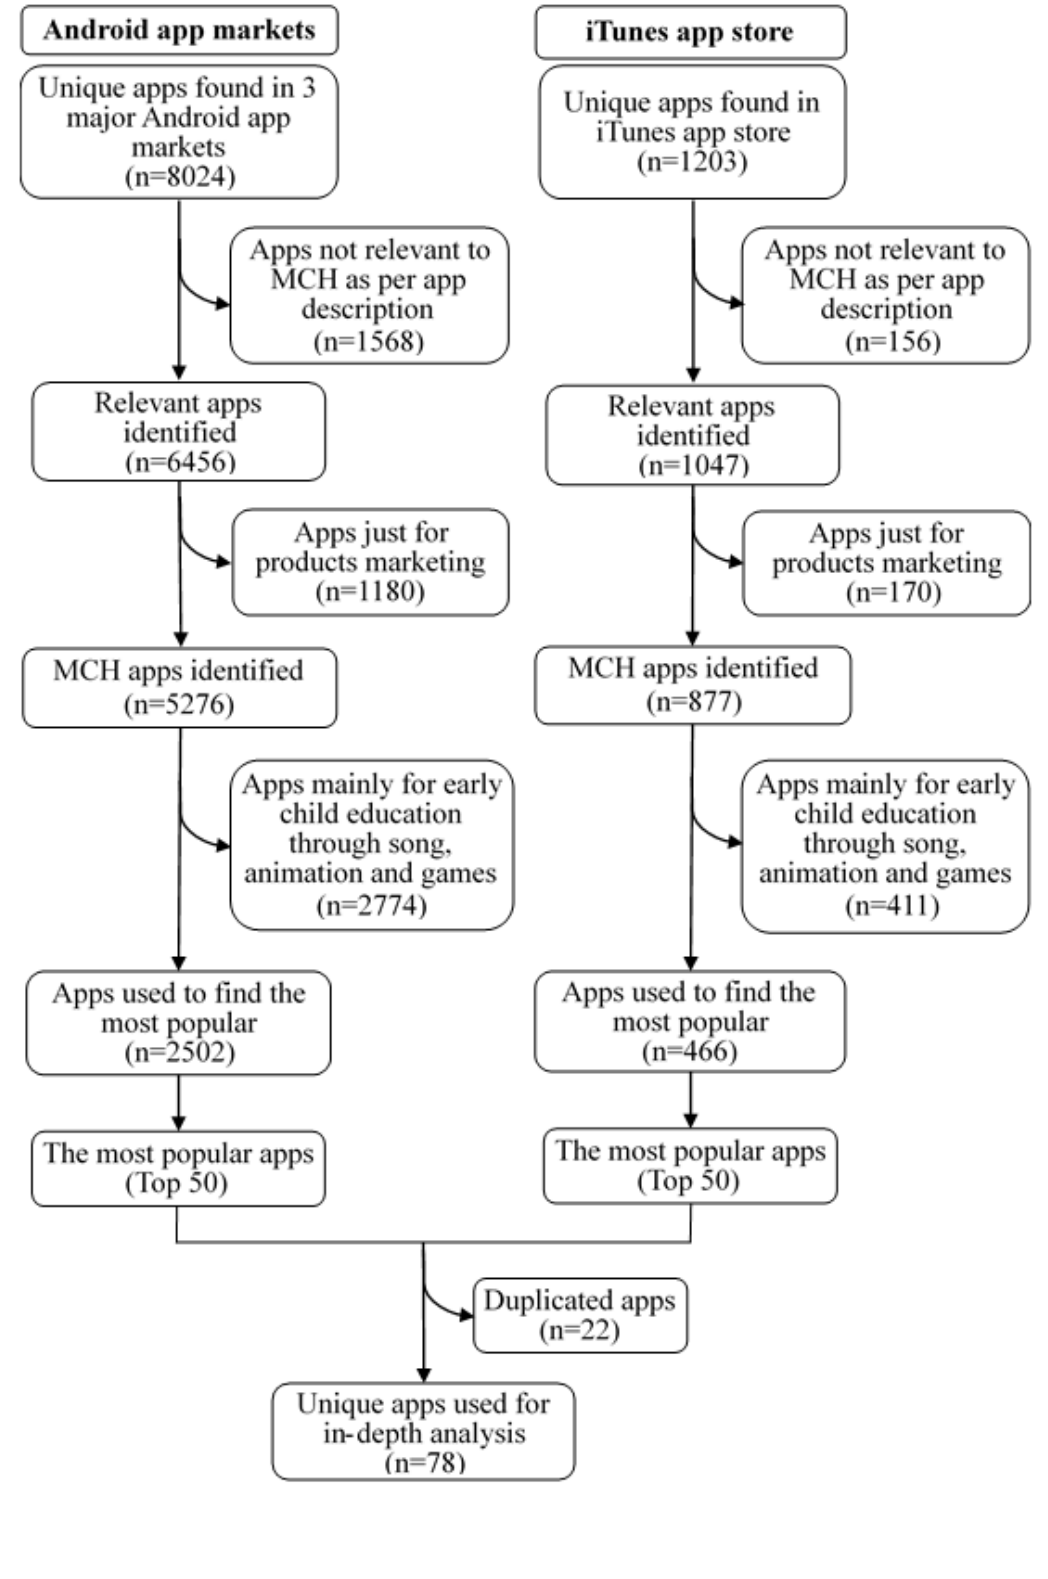
Figure 1. Flowchart of app selection for maternal and child health. MCH: maternal and child